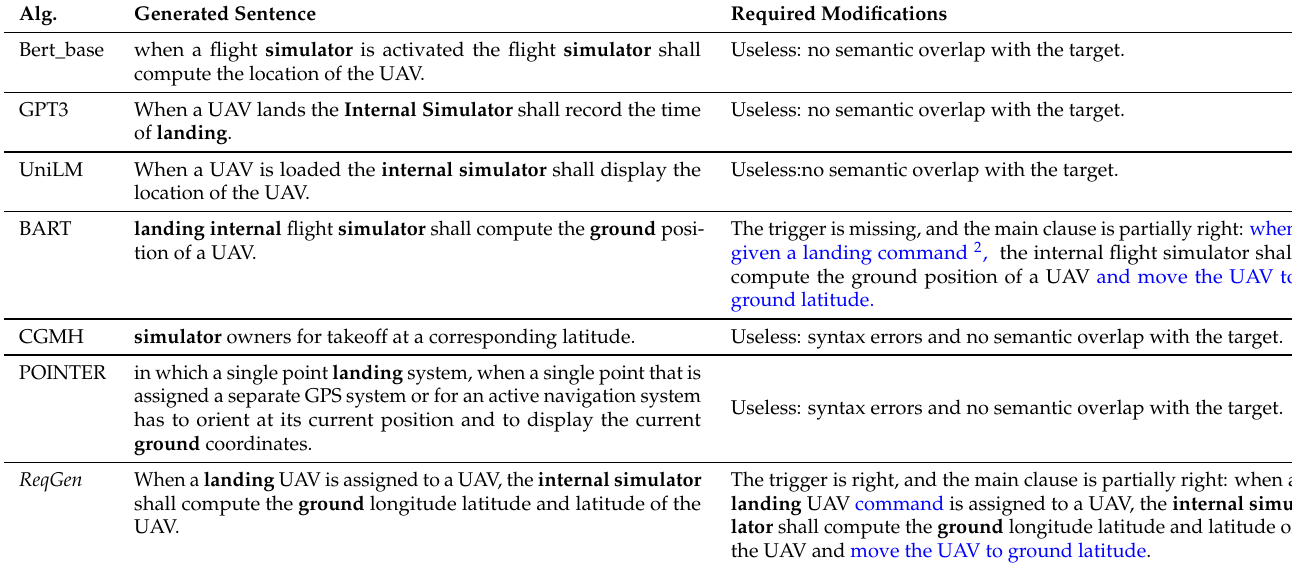
Table 2. Examples showing the requirements generated by the baselines and our method from